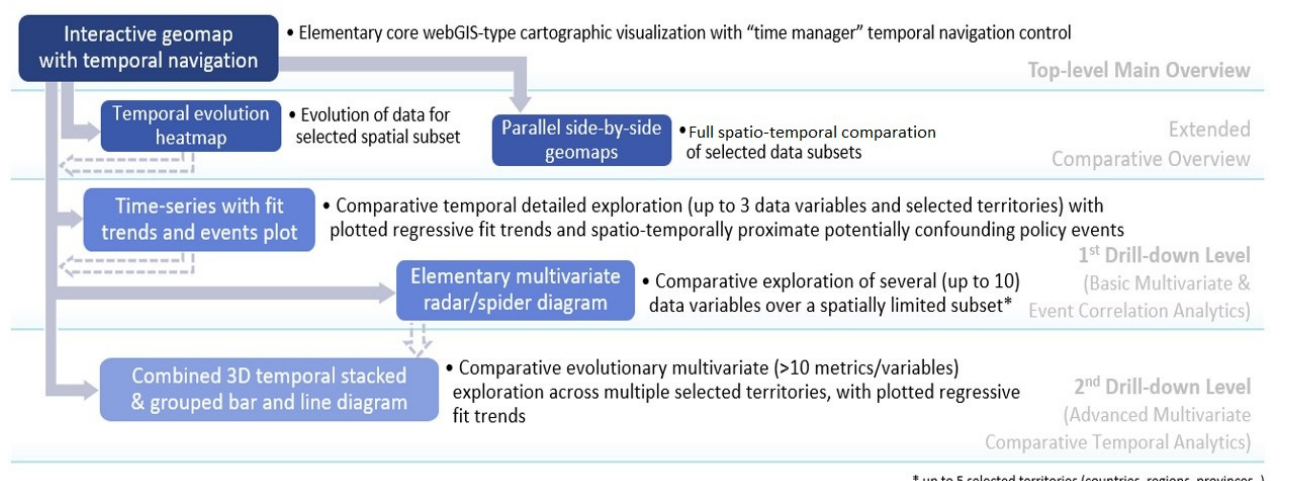
Figure 6. Atlas analytics workflow.